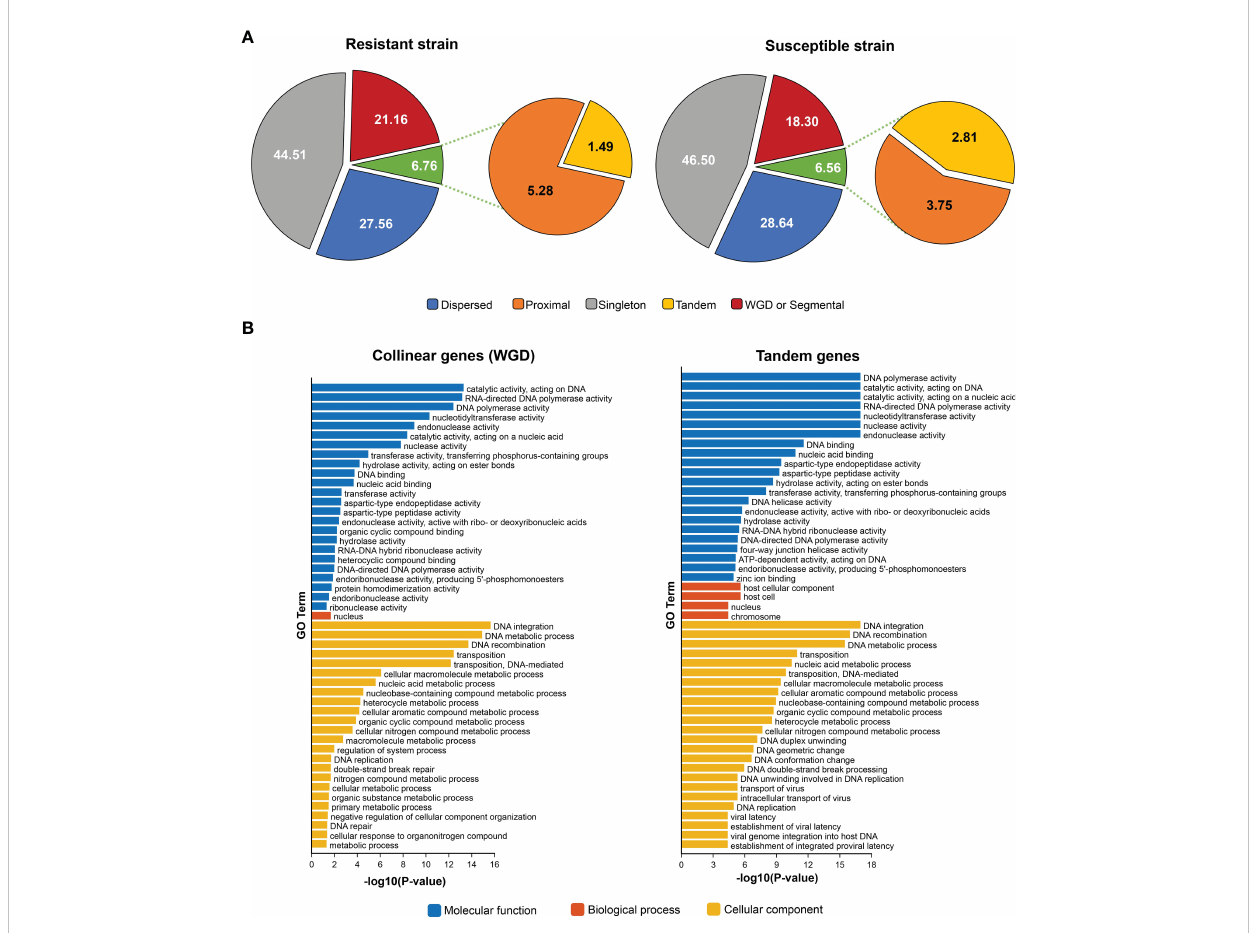
FIGURE 2 Gene types and enrichment of GO annotation of duplicated genes. (A) : gene type categories found in the resistant and susceptible strains after syntenic alignments evaluation by MCScanX. (B) : Enrichment of GO annotations according to Molecular Function, Biological Process, and Cellular Component categories (level 3) of collinear and tandem duplicated genes in the resistant and susceptible